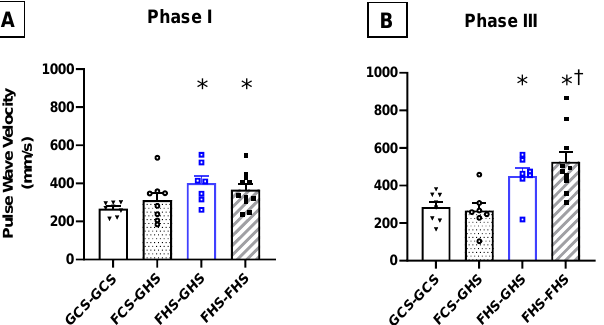
Figure 2. Pulse Wave Velocity at the end of Phases I and III. Pulse wave velocity (PWV) of the ascending aorta assessed ( A ) at the end of Phase I and ( B ) at the end of Phase III. Group labels are as described in the legend for Table 1. Values are the mean ± SE; n as depicted on the graphs. * p < 0.05 vs. GCS-GCS (by one-way ANOVA); † p < 0.05 vs. FHS-FHS in Phase I (by two-way ANOVA with repeated